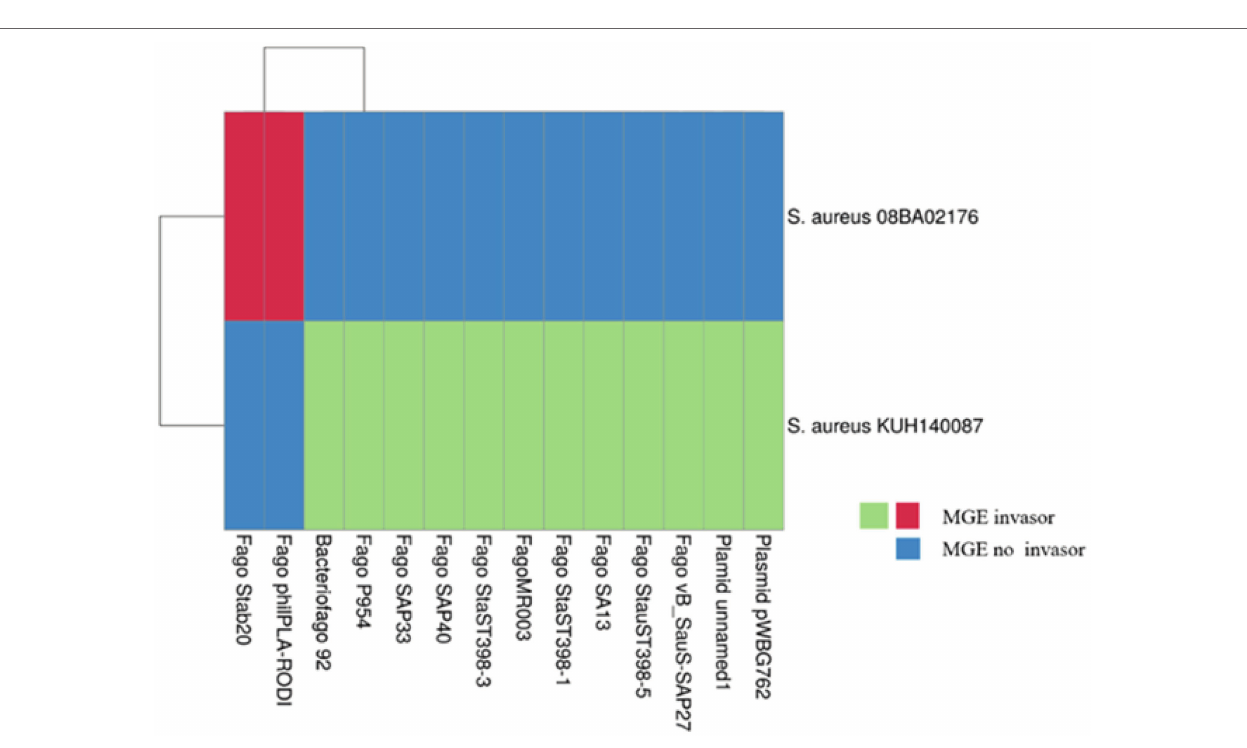
FIGURE 5 | CRISPR-Cas ported strains that exhibited information of known mobile genetic elements (MGE). The annotations of the heat map were appended. The strains shown are unique, in which some of the spacer sequences were associated with an MGE through BLAST. The map was obtained in